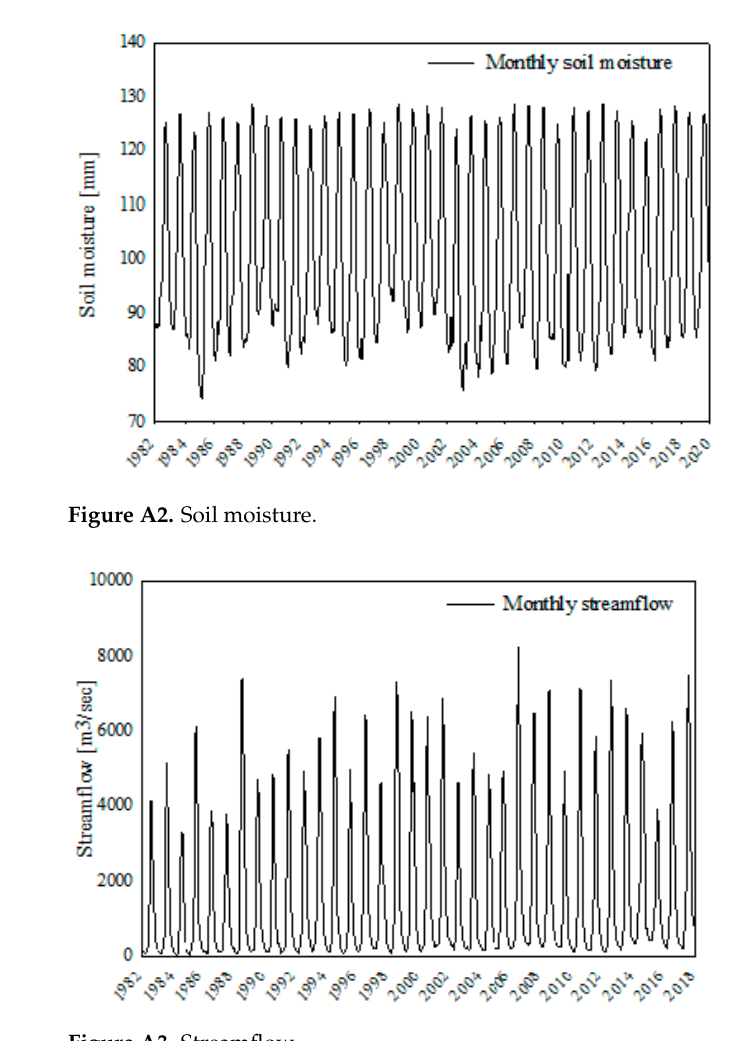
Figure A3. Figure A3. Streamflow.